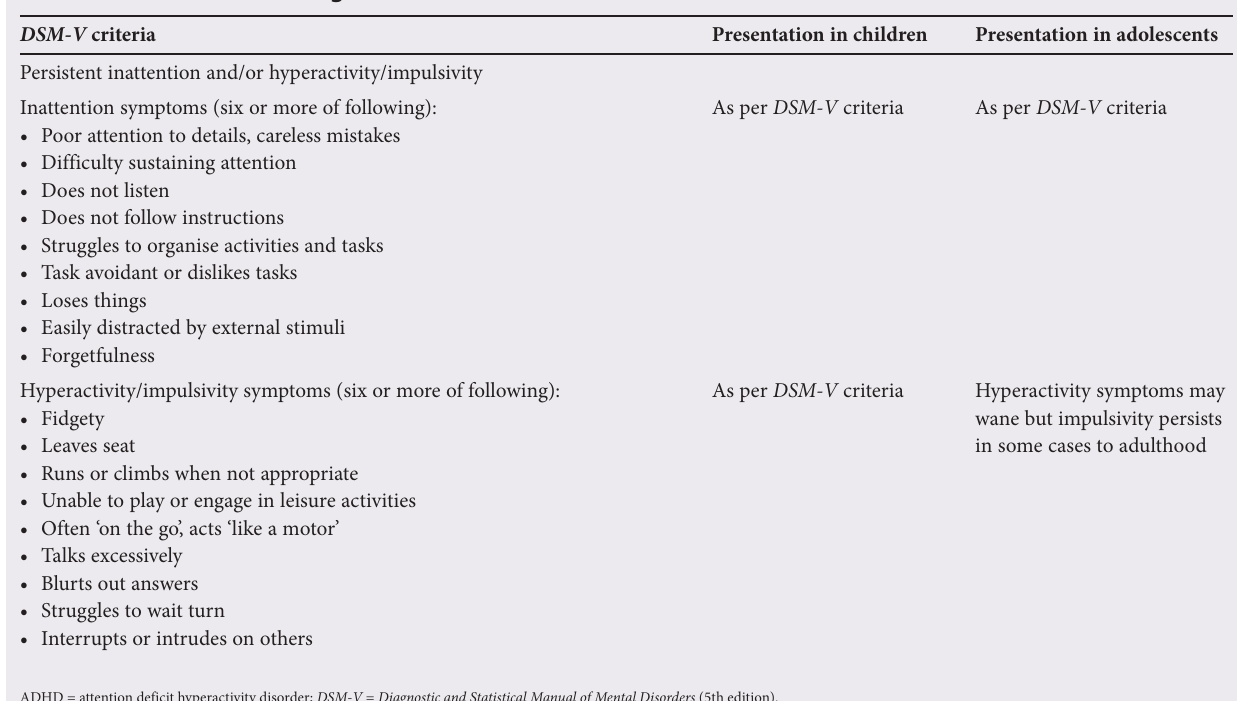
Table 4. Assessment and diagnosis of ADHD [5] DSM-V criteria Presentation in children Presentation in